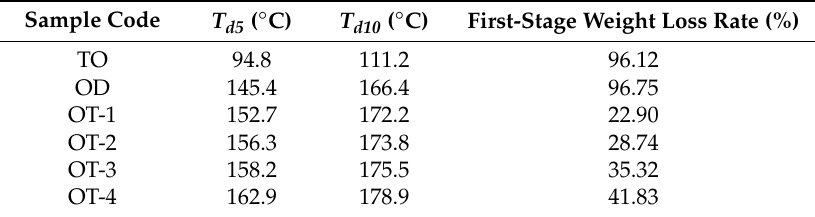
Table 2. The TGA results of pure cores and various composite microcapsules.